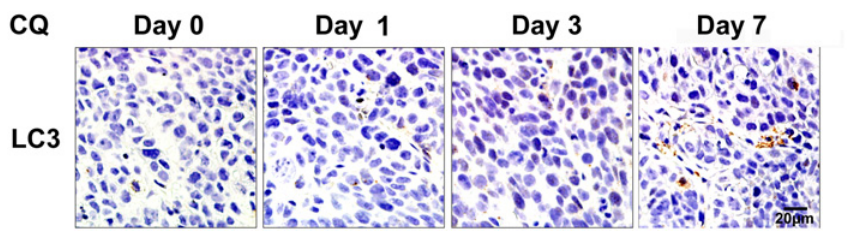
Fig 5. Delayed effects of autophagy inhibition by CQ in xenograft tumors. Tumors treated with CQ (60 mg/kg/day) were collected after treatment for 1, 3 and 7 days and sectioned for LC3 immunohistochemistry. Scale bar = 20 μ